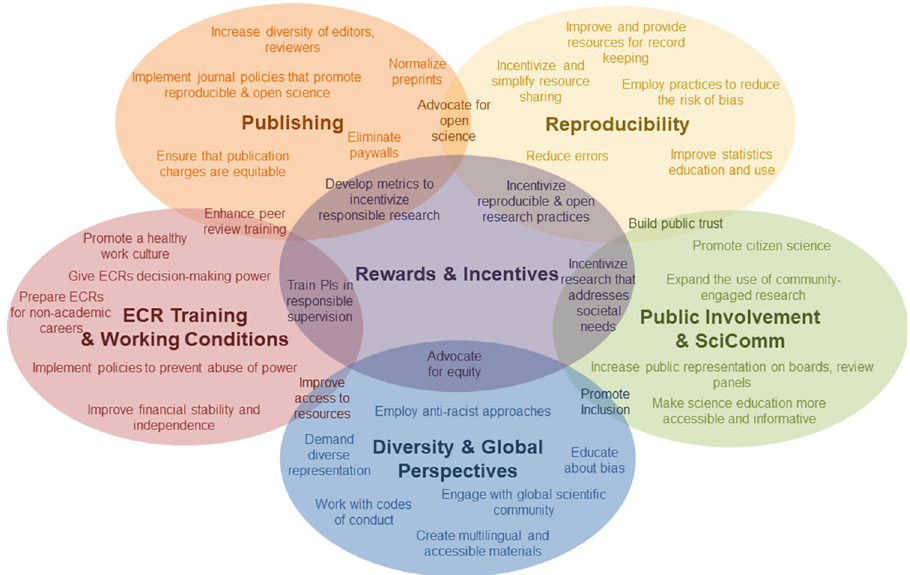
Fig 1. Themes of scientific reform efforts. Common themes of science reform work include publishing, reproducibility, public involvement and science communication, diversity and global perspectives, ECR training and working conditions, and rewards and incentives. This figure provides a general overview of some themes included in each topic and overlapping areas. It is impossible to display all themes and overlapping areas.